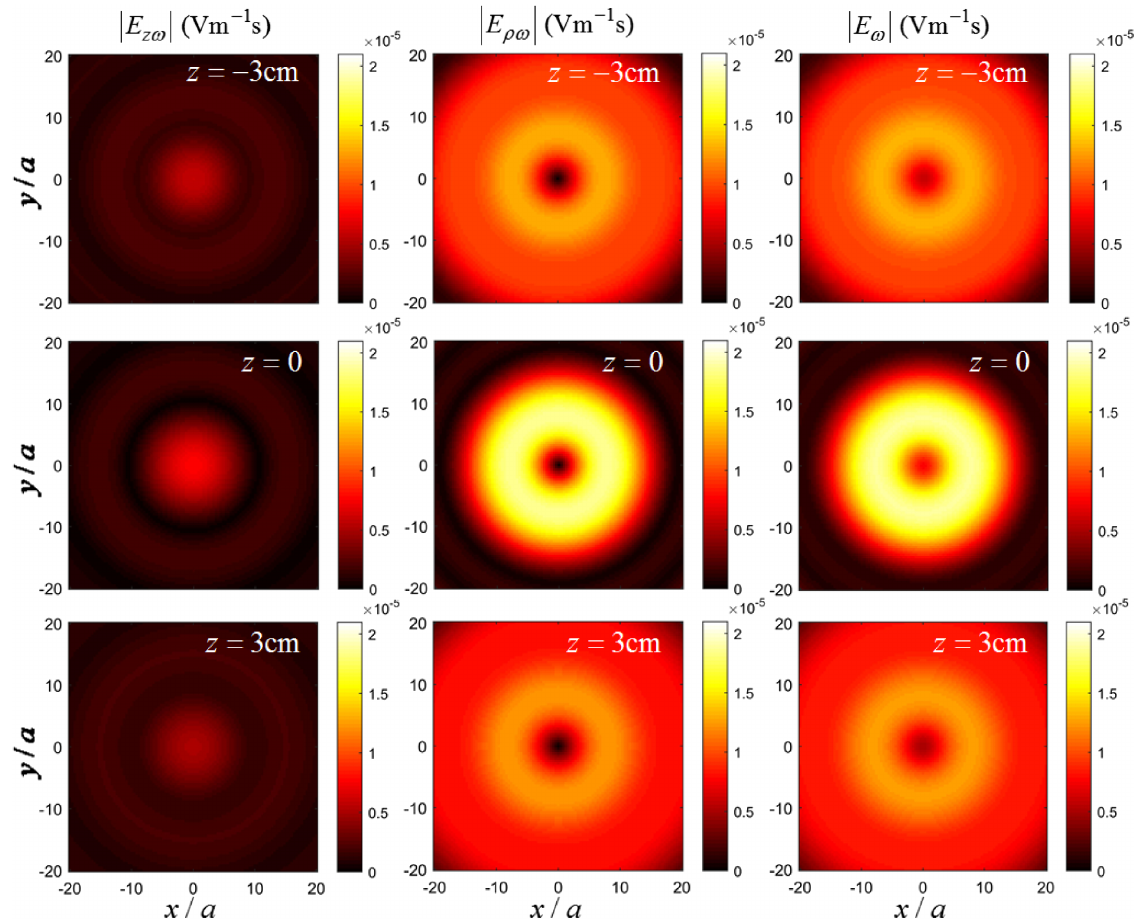
FIG. 3. Two-dimensional distribution of the absolute values of the longitudinal ( E over xy -plane for symmetrical case r 0 ¼ 0 . Plane z ¼ z given in Table